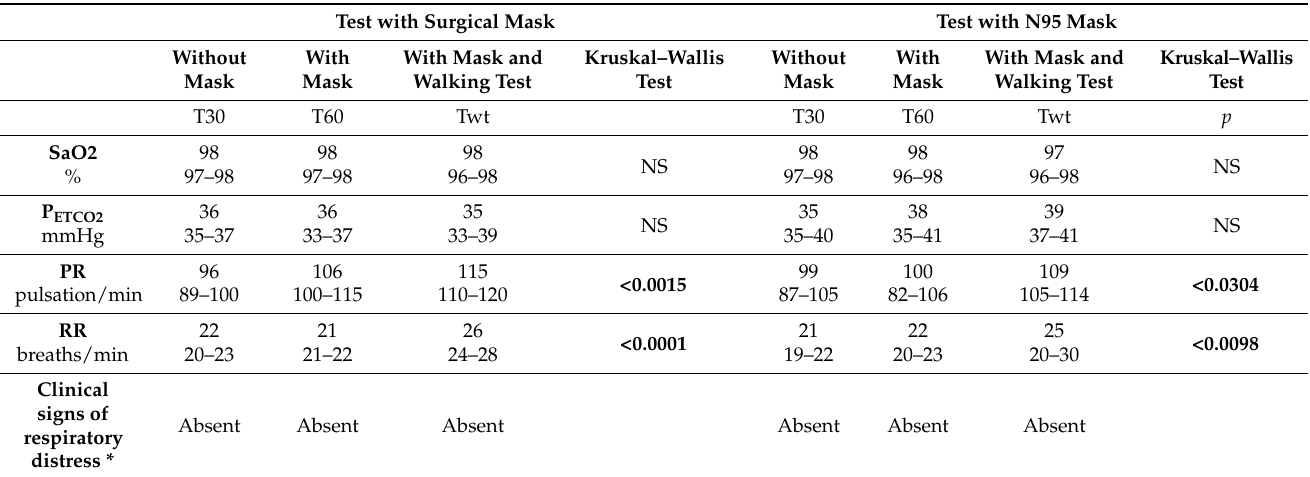
Table 2. Oxygen saturation (SaO2), partial pressure of end-tidal carbon dioxide (P ETCO2 ), pulse rate (PR), respiratory rate (RR), and the occurrence of clinical signs of respiratory distress during the test, at 30 (cid:48) (T30), at 60 (cid:48) (T60) minutes and after a 12 min walking test (Twt) in all healthy children wearing a surgical mask (SM) and N95 mask (N95). All data are expressed as median, 25th, and 75th